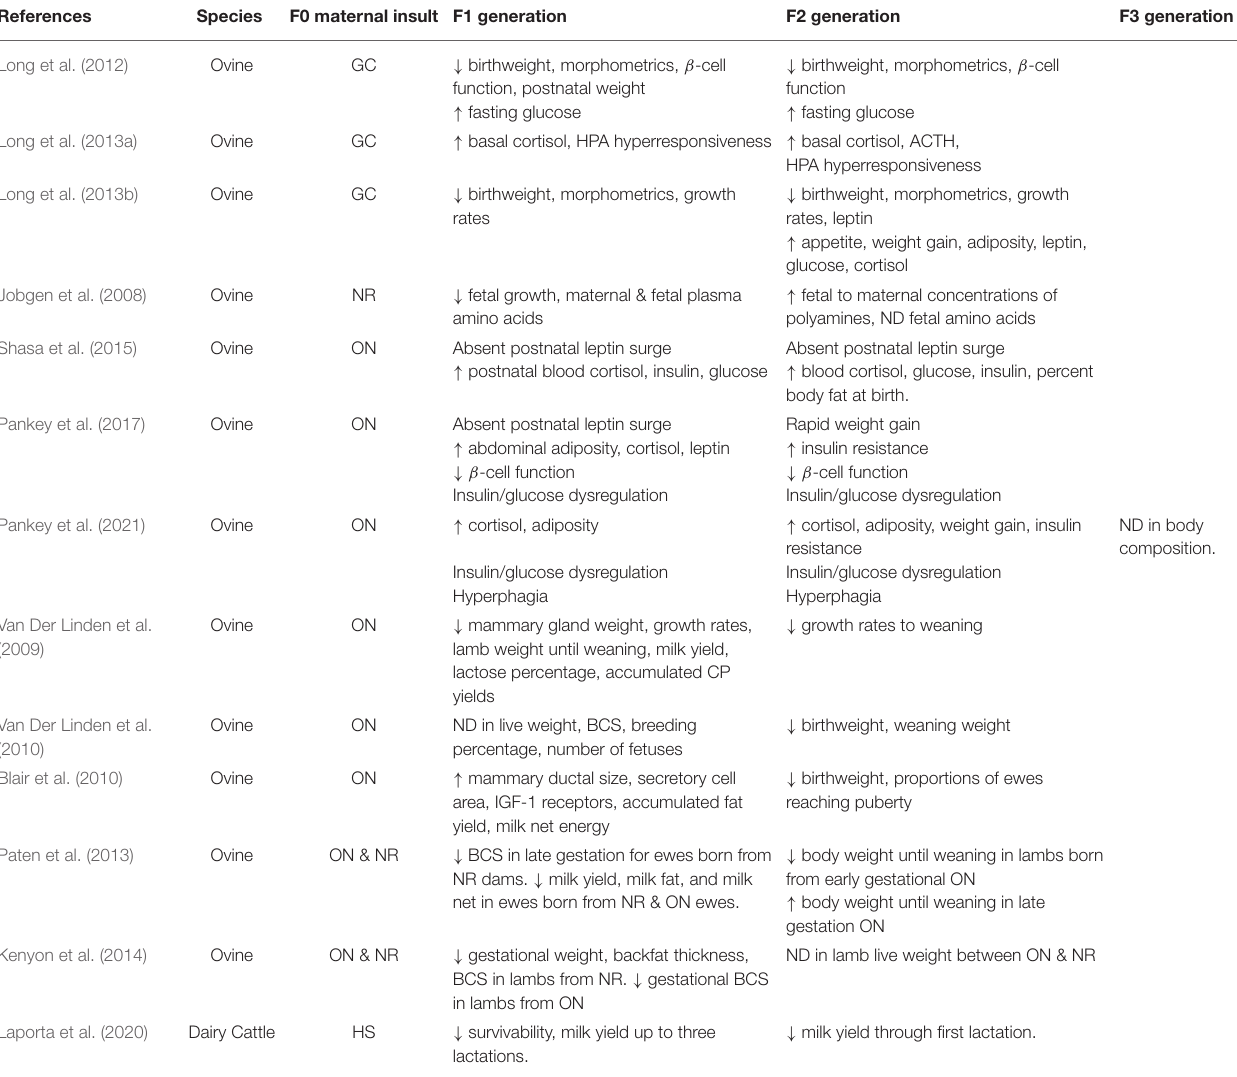
TABLE 1 | Studies showing intergenerational effects of maternofetal stress in ruminant